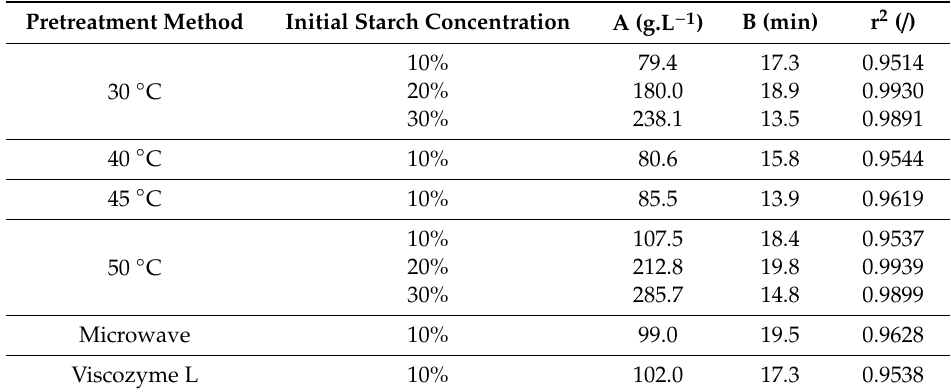
Table 3. Summary of the results obtained by fitting Equation (5) to the experimental progress curves for the hydrolysis of cassava